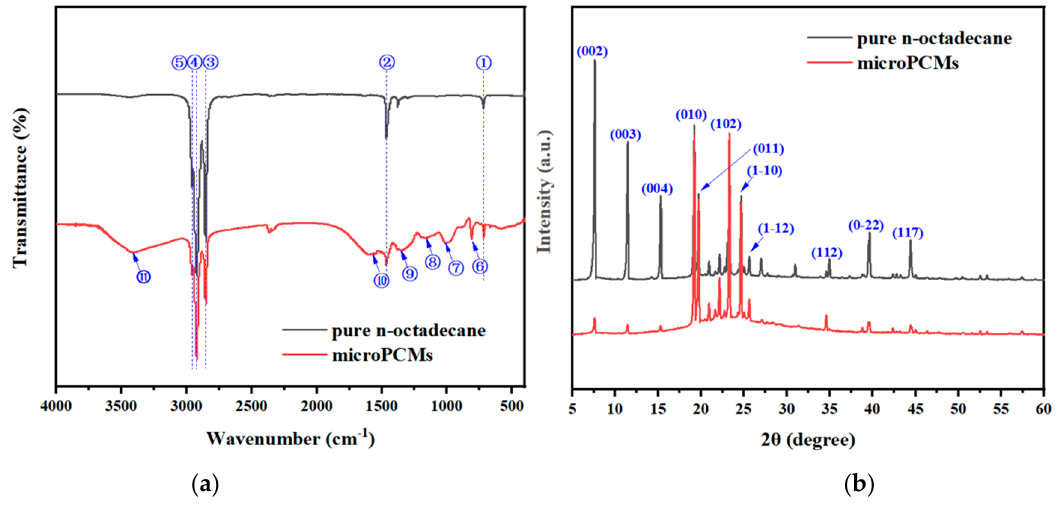
Figure 4. ( a ) FTIR spectra and ( b ) XRD patterns of n -octadecane and microPCMs. Table 2. Main infrared absorption characteristic peaks of microPCMs and n